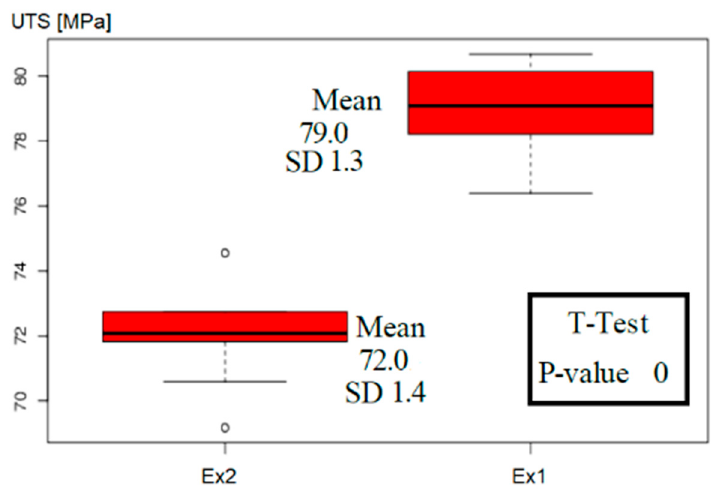
Figure 10. The results of two-sided t-tests of UTS measurements showing that Ex1 and Ex1 do not follow the same distribution. The test was done with 95% confidence.